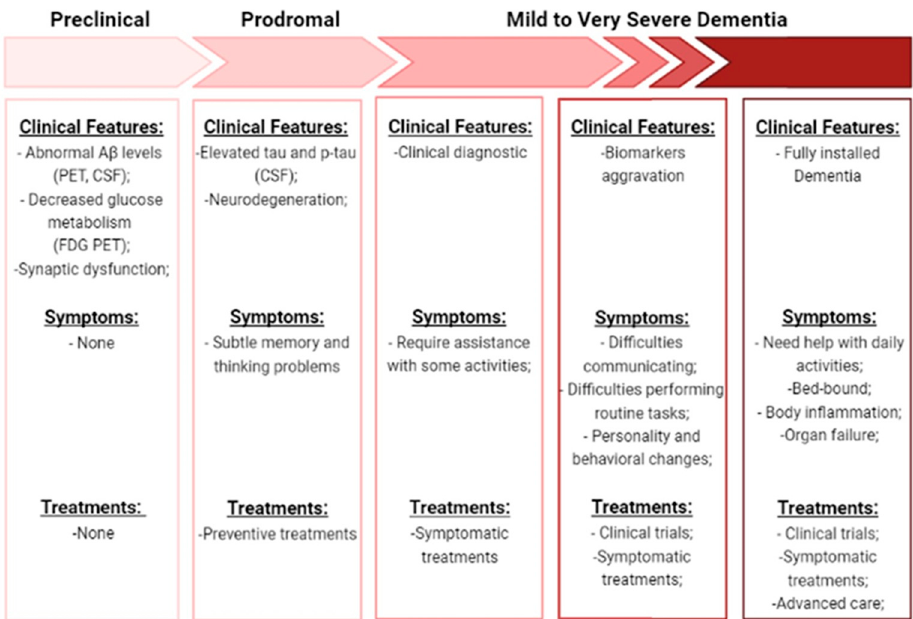
Figure 2. Description of the progression along the seven stages of AD. Is shown the clinical features, symptoms, and treatments specific to each stage. (A β —amyloid beta-peptide; PET— positron emission tomography; FDG—18F-fluorodeoxyglucose; CFS—Cerebrospinal fluid; p-Tau—